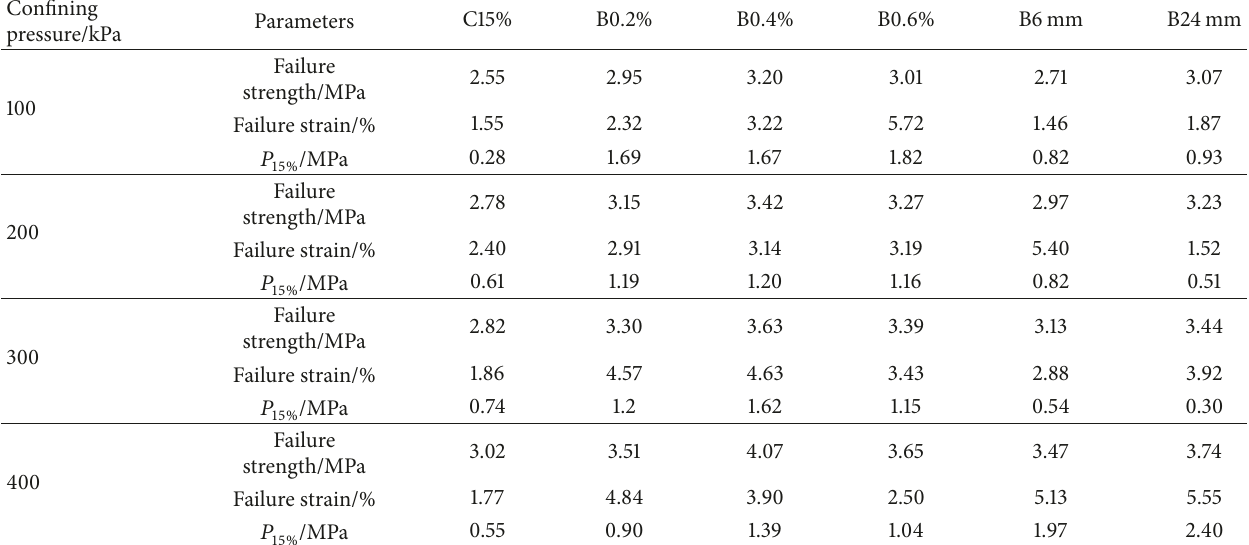
Table 7: Related parameters of shear stress and shear strain after 28 days.